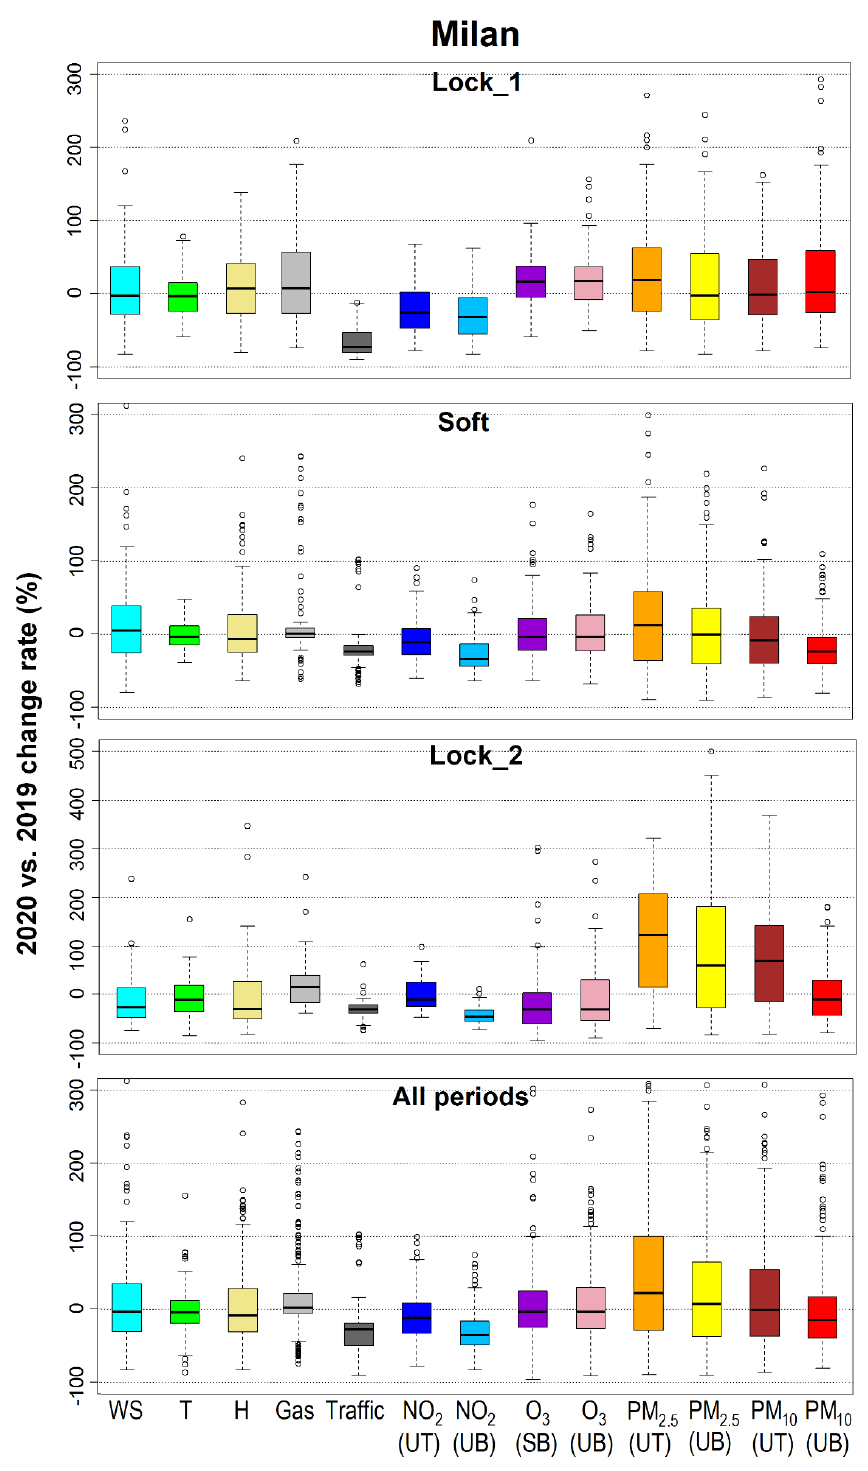
Figure 3. Boxplots by period of 2020 vs. 2019 change rates of daily observations in Milan: concen- trations by station type of NO 2 , O 3 , PM 2.5 , and PM 10 ; wind speed ( WS ); air temperature ( T ); PBL height ( H ), gas consumption; road traffic. Boxplots are delimited by the first ( Q 1 ) and third ( Q 3 ) distribution’s quartiles, while the black line inside the box denotes the median value ( Q 2 ). Lower whisker is Q 1 − 1.5*IQR , while upper whisker is Q 3 + 1.5*IQR , where the interquartile range ( IQR ) is Q 3 − Q 1 . Circles outside the whiskers denote outlier data.